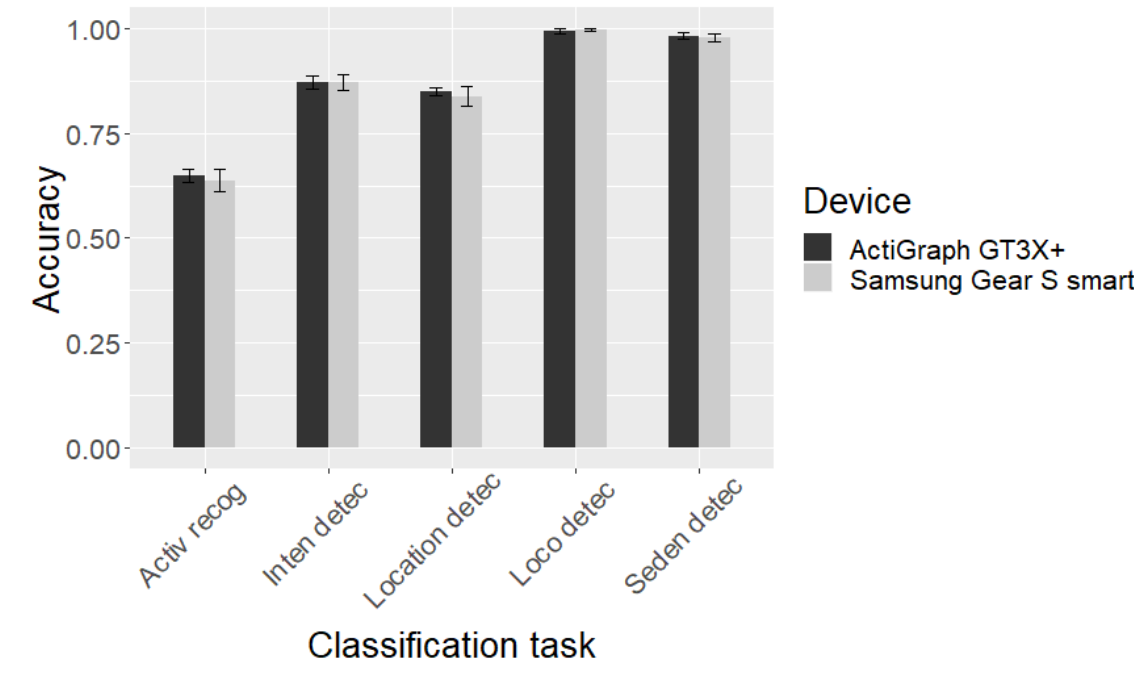
Figure 9. Accuracies of the 5-fold cross-validation classification tasks performed on Samsung Gear S smartwatch data and ActiGraph GT3X+ data. We used the best model and best window length (random forest model and 16-second window length feature extraction). Activ recog: Activity recognition; Inten detec: Activity intensity level detection; Location detec: Major body movement location detection; Loco detec: Locomotion detection; Seden detec: Sedentary activity